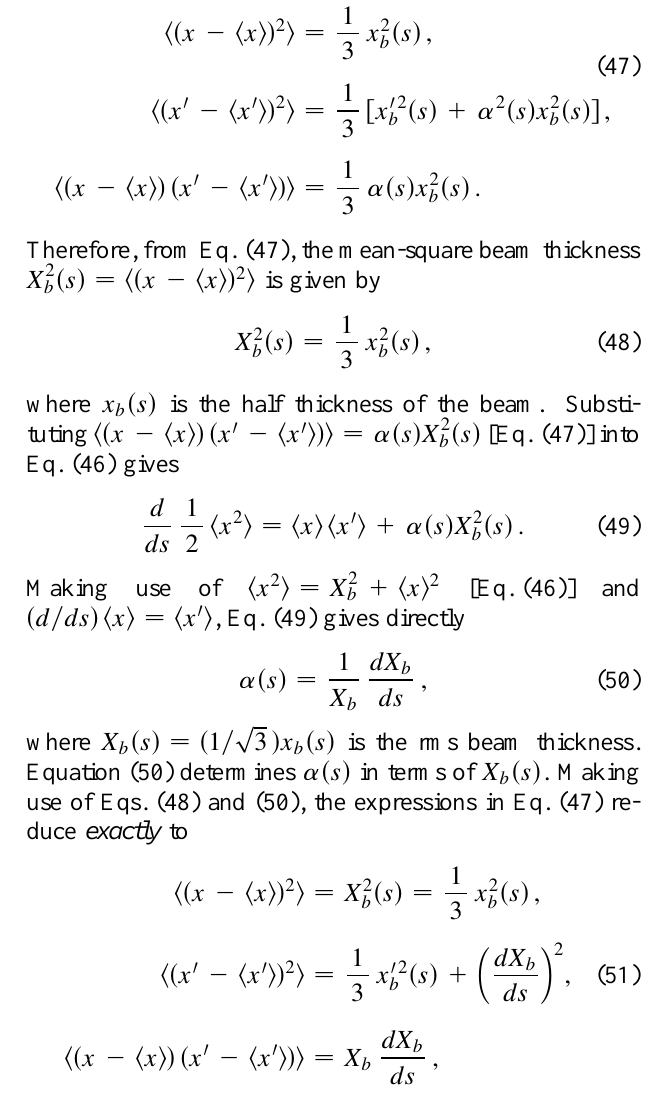
for the choice of distribution function in Eq. (40) and Fig. 2. The unnormalized beam emittance (subtracting out the centroid motion) defined in Eq. (20) is a quantity of con- siderable physical interest. Making use of Eqs. (20) and (51), we obtain